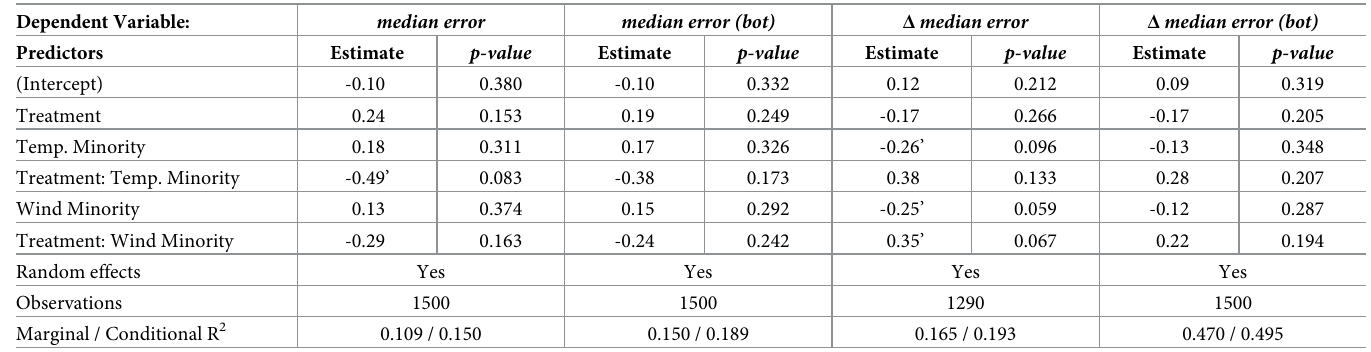
Table 4. Mixed model estimates of treatment effect on team